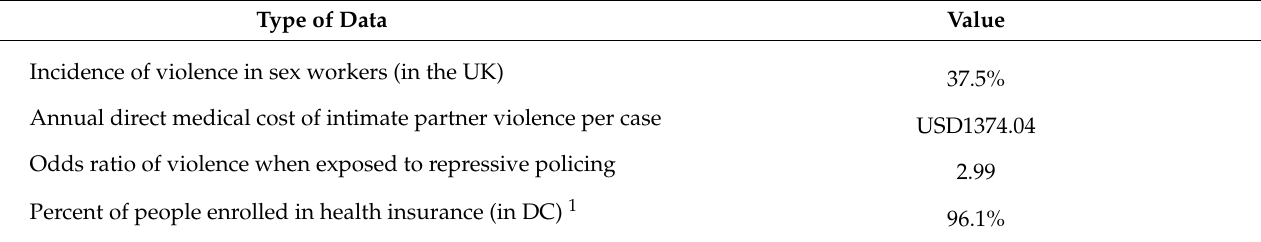
Table 3. Values of data used to calculate health sector savings due to averted cases of violence following decriminalization (monetary values in 2020